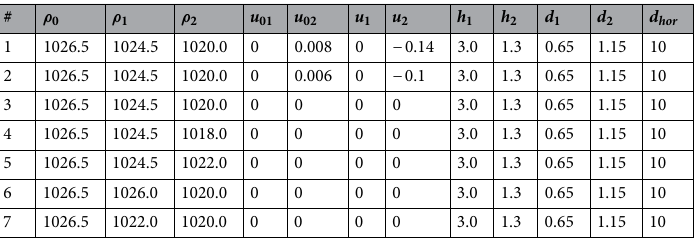
Table 1. Parameter values (in S.I.) used for each simulation carried